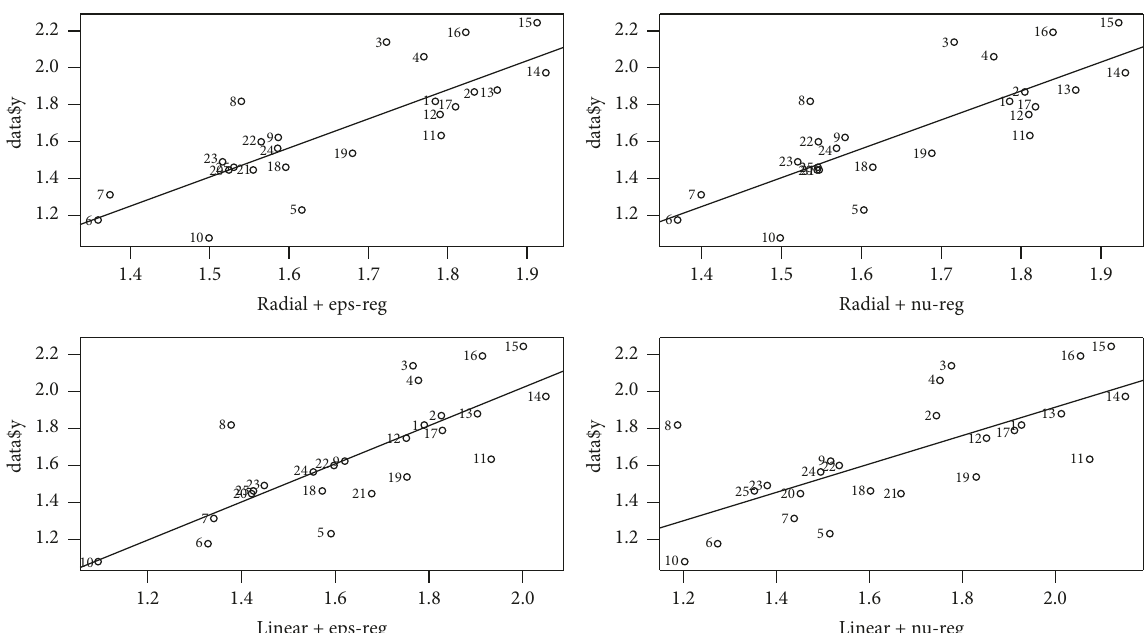
Figure 2: Scatter plot of experimental values and 4 SVM models’ prediction results of lgt1/2. Note . The horizontal coordinates, respectively, represent the predicted values of lgt1/2 of 4 SVM models, and the longitudinal coordinates express the experimental results.